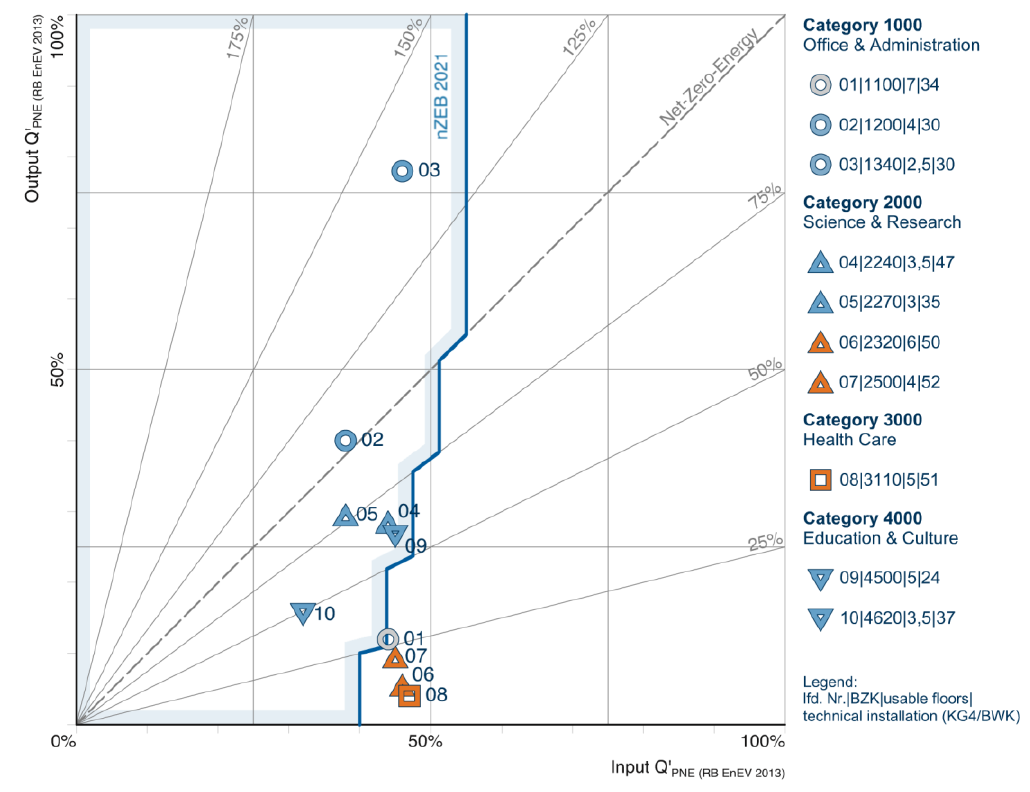
Figure 7. Input-output balance (Q’ PNE ) relative to reference building (RB = 100%)—Summary of case studies for standard nZEB 2021.